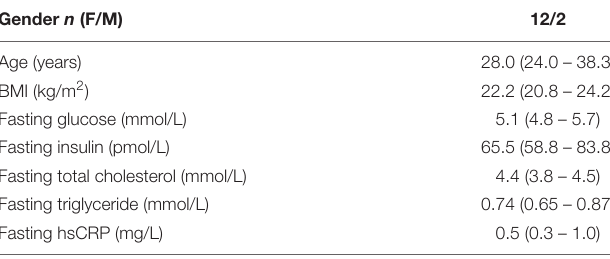
TABLE 2 | Baseline characteristics of participants.